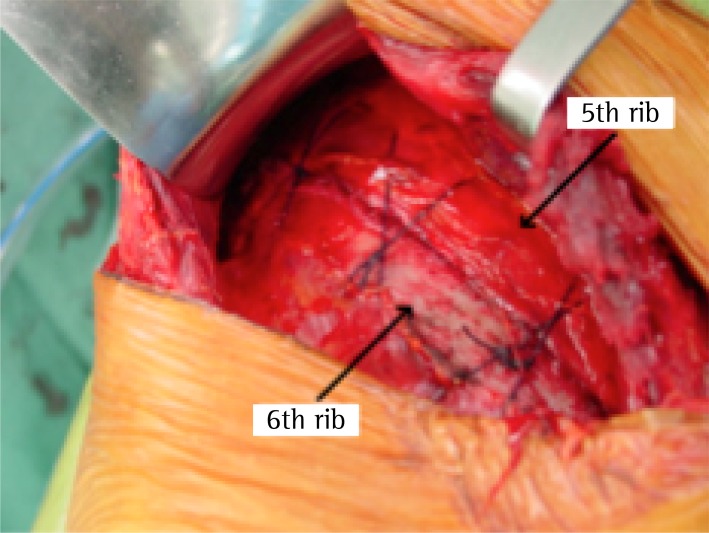
Técnica de fechamento por sutura pericostal.